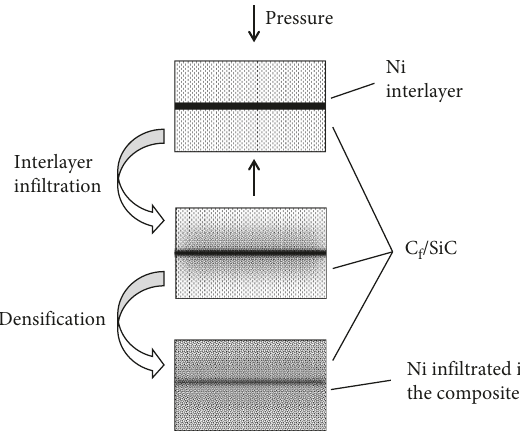
Figure 5: The diagram of self-joining using Ni